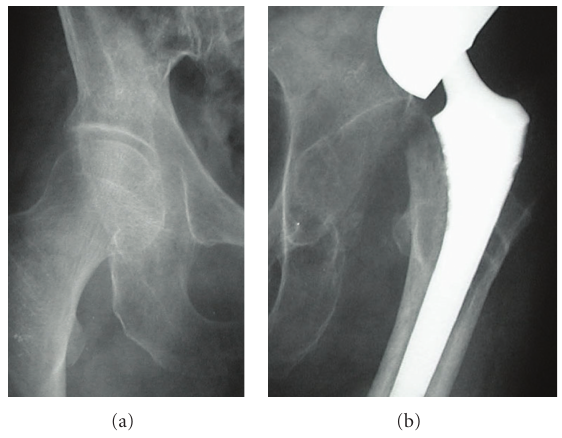
Figure 4: The outer head is dislocated completely. The outer part of the subchondral bone is inclined in the superior direction.